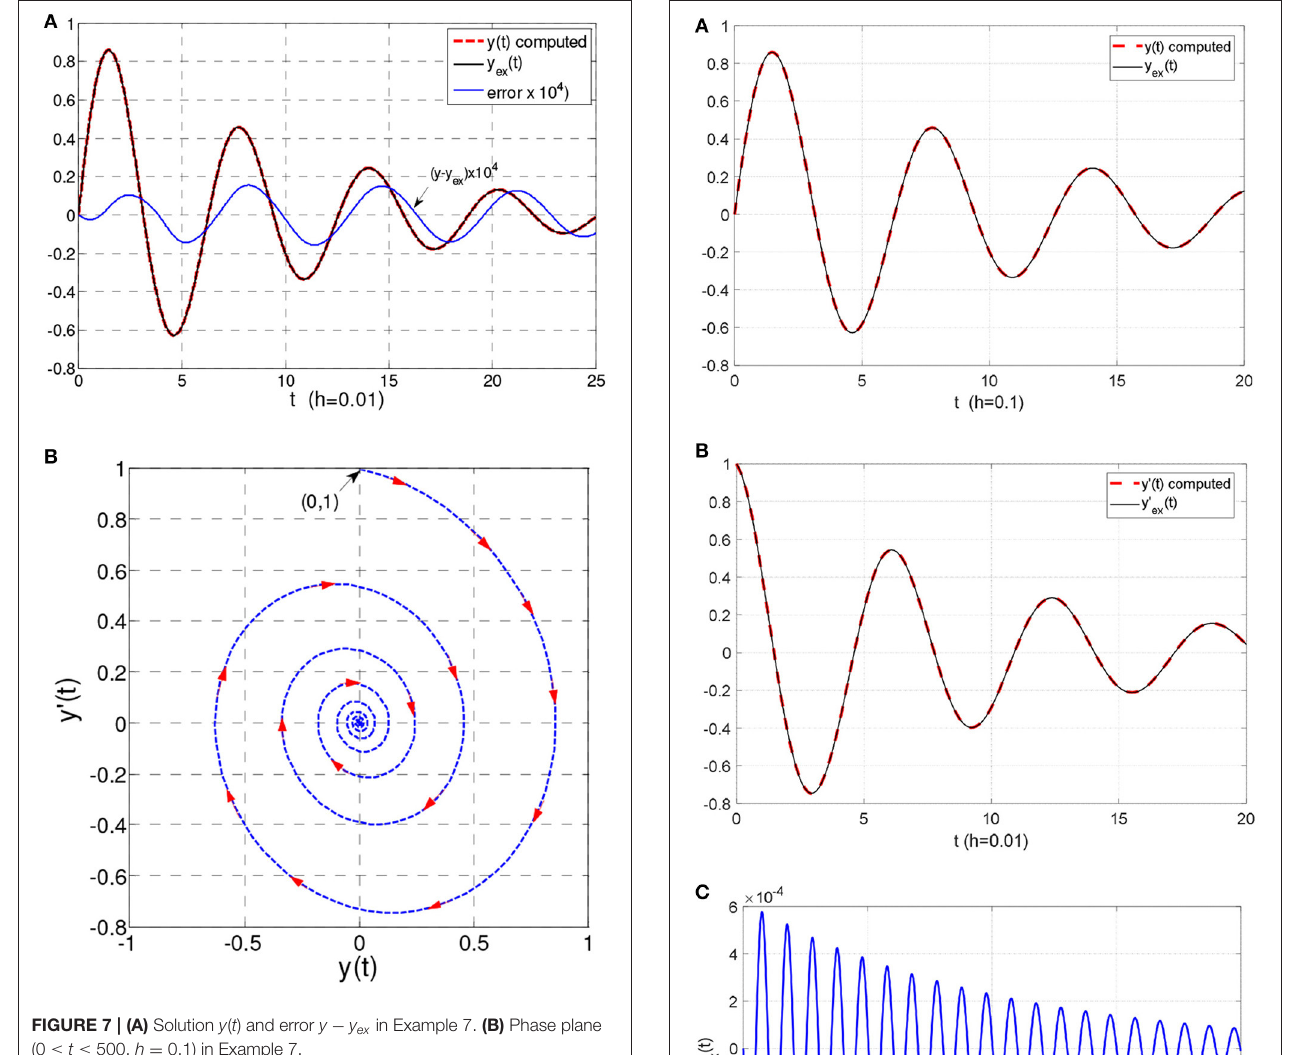
FIGURE 7 | (A) Solution y ( t ) and error y t (0 500, h 0.1) in Example 7. ≤ ≤ =